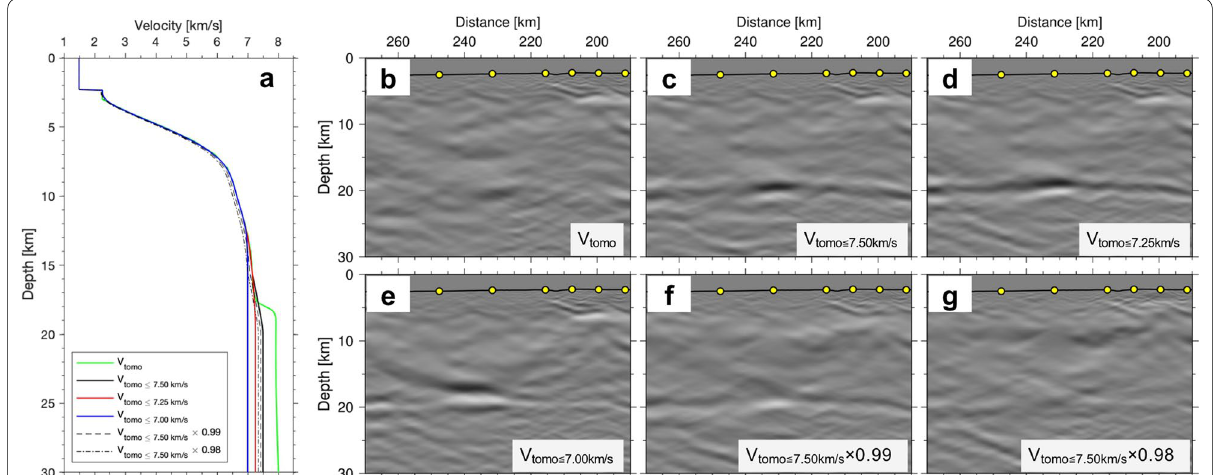
Fig. 5 Comparison of RTM images obtained from different velocity models. a Vertical velocity profiles, which correspond to RTM images in b – g , at a horizontal distance of 230 km. RTM images from b the original traveltime tomography result and velocity models limited to c 7.5 km/s, d 7.25 km/s, and e 7.0 km/s and scaled by f 99% and g 98% after the upper limit to 7.5 km/s. The yellow dots indicate OBS